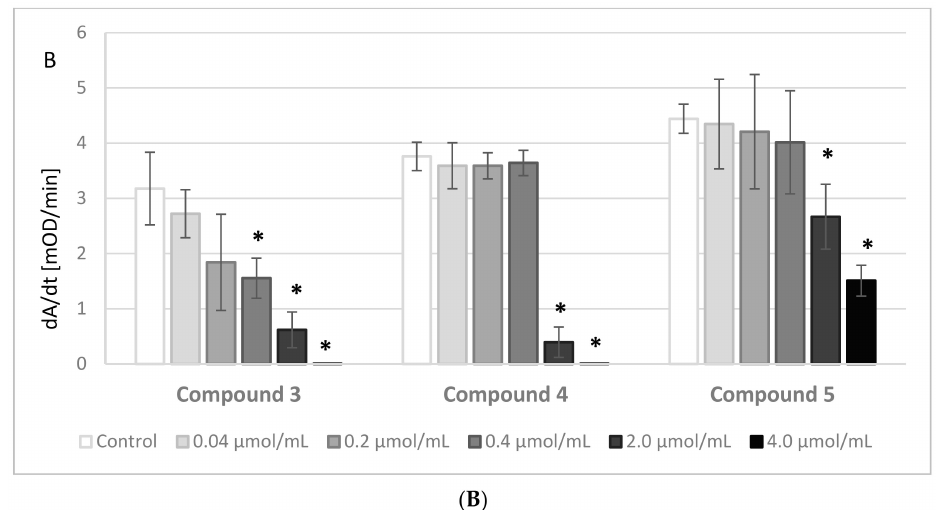
Figure 3. The effects of iminodiacetic acid derivatives ( A ) compounds 1 and 2 ; ( B ) compounds 3–5 on amidolytic activity of thrombin expressed as velocity of the enzymatic reaction (dA/dt). The results are presented as mean ± SD, n = 4 after 3 min incubation in plasma; final volume 500 µ L. All compounds statistically significantly decreased the velocity of the enzymatic reaction, depending on their concentration; * p <